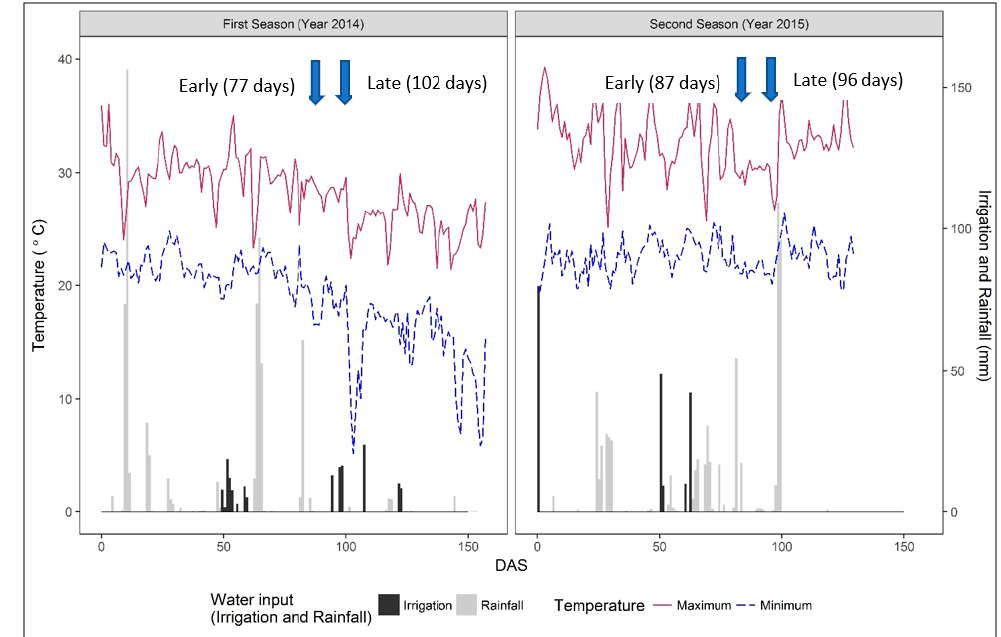
Figure 1. Rainfall, irrigation, and temperature in Alton Downs, Queensland (QLD), during the rice growing period in 2014 and 2015 (first season: sowing = 22 January 2014, harvest = 28 June 2014; second season: sowing = 14 November 2014, harvest = 23 March 2015). Arrows indicate date of flowering for early and late varieties. DAS = days after sowing.